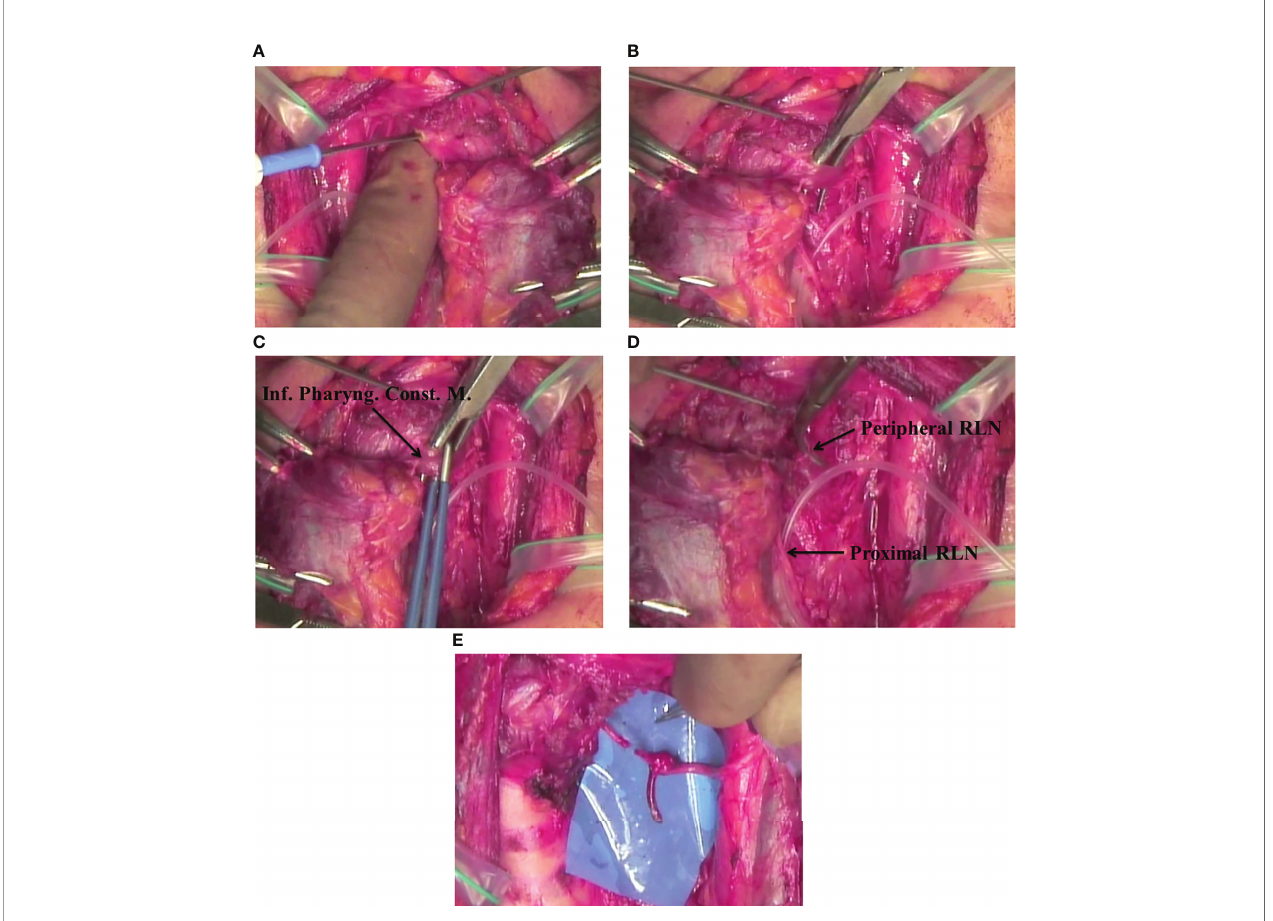
FIGURE 5 | (A) Laryngeal approach: Marking a hole in the inferior pharyngeal constrictor muscle at the lateral edge of the thyroid cartilage using electrocautery. (B) Laryngeal approach: Dissection of the inferior pharyngeal constrictor muscles along the lateral edge of the thyroid cartilage. (C) Laryngeal approach: Cutting the inferior pharyngeal constrictor muscles along the lateral edge of the thyroid cartilage using a pair of bipolar coagulators. (D) Laryngeal approach: Locating the peripheral RLN behind the thyroid cartilage. (E) Laryngeal approach: Performing ARA with the distal portion of the RLN that was found behind the thyroid supraclavicular cutaneous nerves, transcervical nerves, auricular nerves, and ansa cervicalis, irrespective of the motor or sensory nerves. If the defect extends to the mediastinum, anastomosis at the mediastinal site may be challenging or practically impossible.